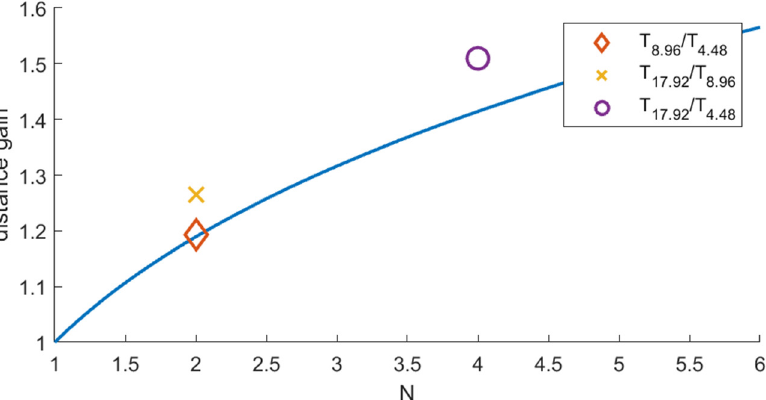
Figure 12. Theoretical (light blue curve) and measured (markers) distance gain towards chirp stretching. N represents the ratio between chirps ʹ temporal durations.